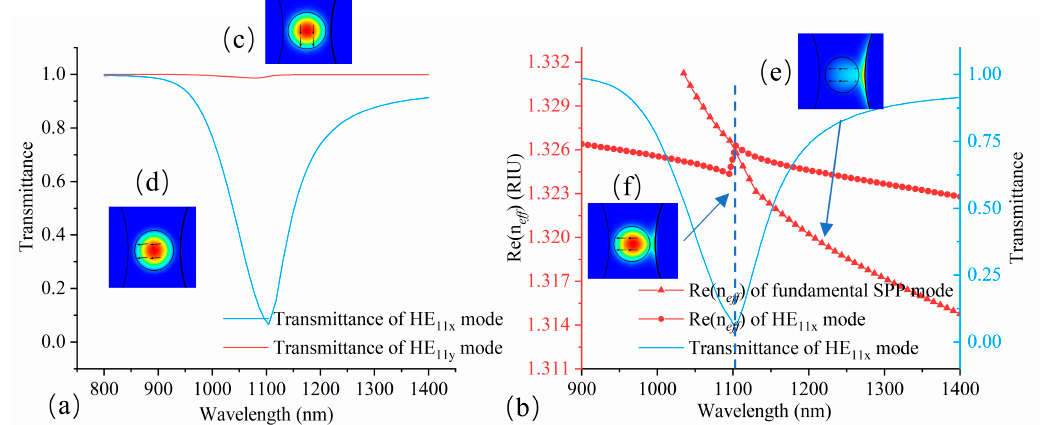
Figure 3. ( a ) The transmittances of the two core modes of the sensor. ( b ) Dispersion relations of the core modes and the fundamental surface plasmon polariton (SPP) mode for the proposed sensor. Re(n eff ) is the real part of the effective refractive index of modes (n eff ). ( c – f ) Electric field distribution of the different modes. The black arrows are the indicators of the polarization direction. ( c ) Y ‐ polarized HE 11 (HE 11y ) mode. ( d ) X ‐ polarized HE 11 (HE 11x ) mode. ( e ) Fundamental SPP mode. ( f ) Resonance between the HE 11x and the SPP. The simulation parameters are: analyte RI = 1.33, r = 3 μ m, R = 20 μ m, g = 40 nm, t = 50 nm, and d = 1 μ m.